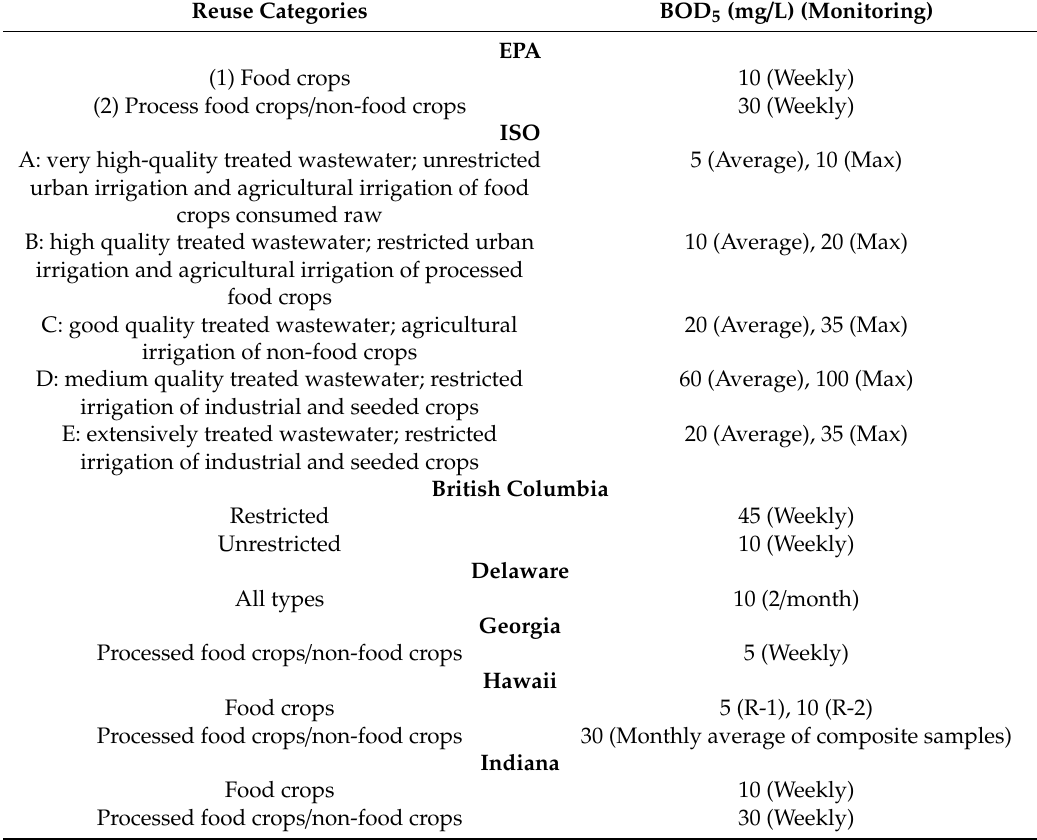
Table 18. BOD 5 thresholds in agricultural water reuse regulations and